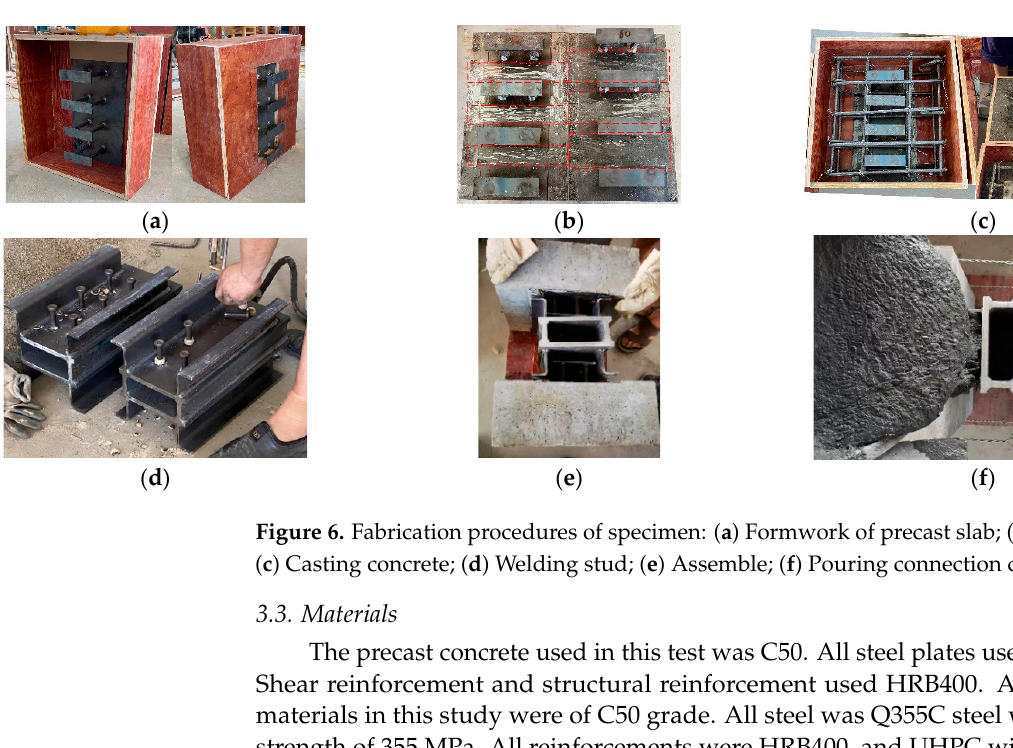
Table 2. Material properties of specimens.